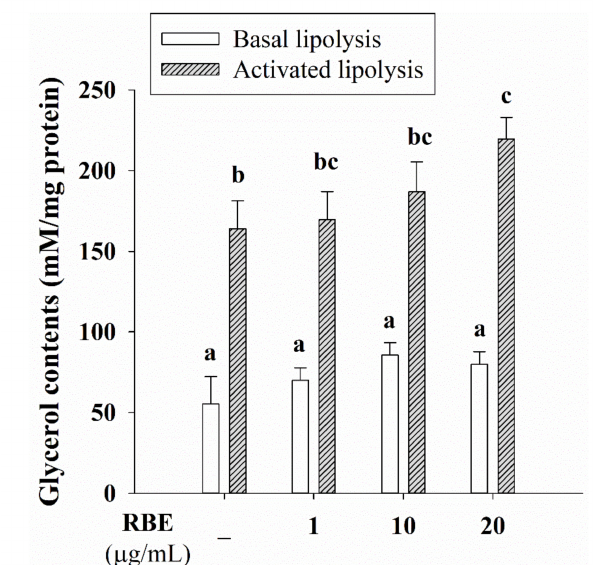
Figure 8. E ff ect of Riceberry rice extract (RBE) on lipolysis in adipocytes. RBE (20 µ g / mL) significantly enhanced isoproterenol-induced glycerol release from adipocytes. The results are expressed as mean ± SEM from the three independent experiments. Groups with a di ff erent letter represent statistical significance ( p <